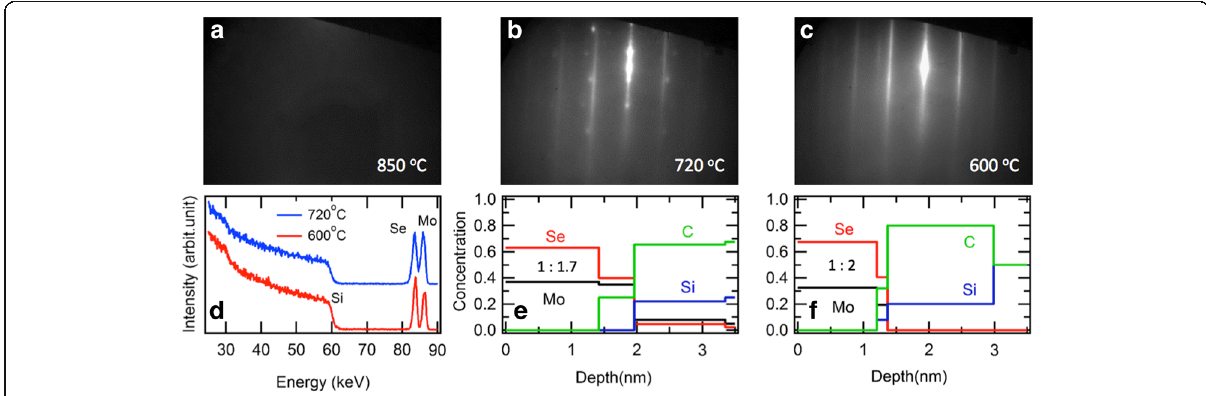
Fig. 5 a – c RHEED pattern of the 2-ML MoSe 2 films after annealing at 850 ( a ), 720 ( b ), and 600 °C ( c ) in UHV condition. d TOF-MEIS spectra of the 2-ML MoSe 2 films after annealing at 720 °C ( blue ) and 600 °C (red). e, f Depth profile of chemical composition of the annealed films at 720 °C ( e ) and 600 °C ( f ), obtained from the TOF-MEIS analysis. Note that the stoichiometric ratio of Mo:Se is 1:1.7 and 1:2 for the 720 and 600 °C samples,